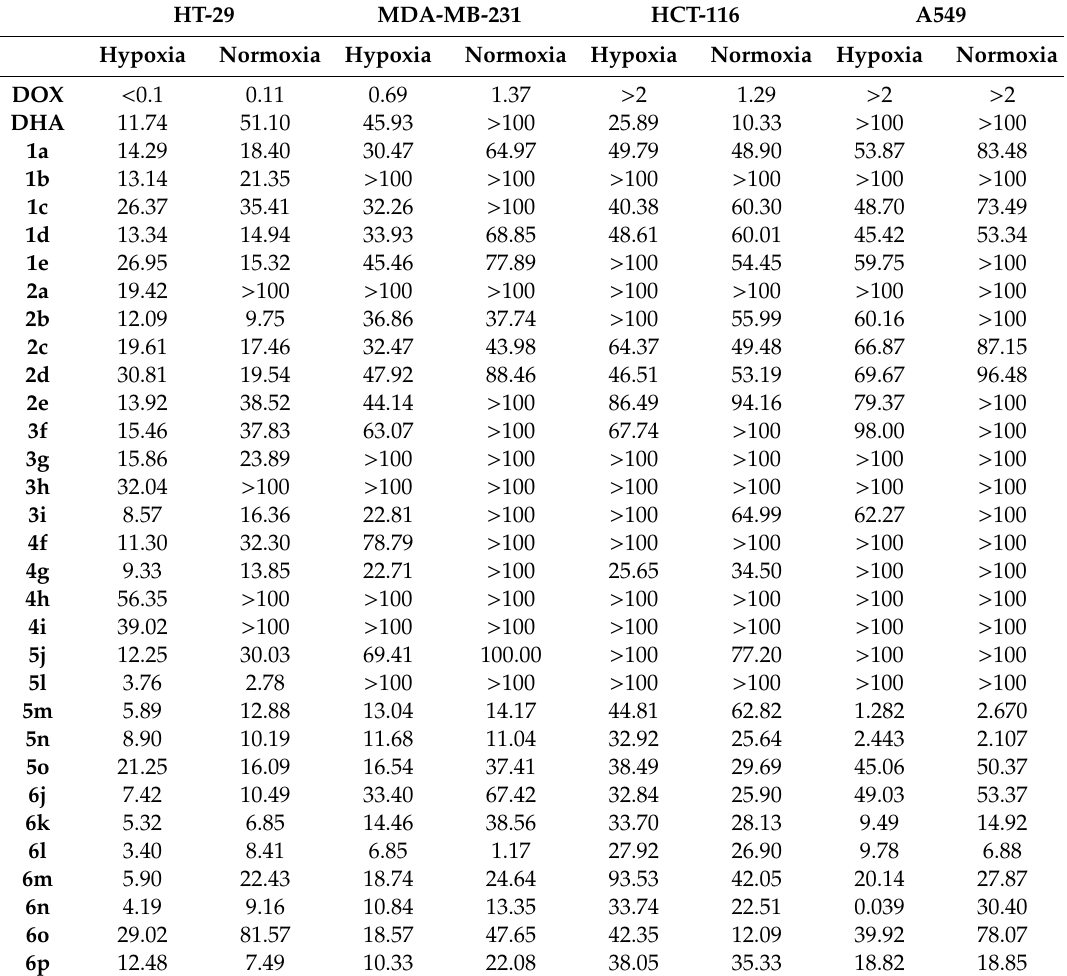
Table 1. IC 50 ( µ M) of tested samples in MDA-MB-231, HT-29, HCT-116, and A549 cell lines. HT-29